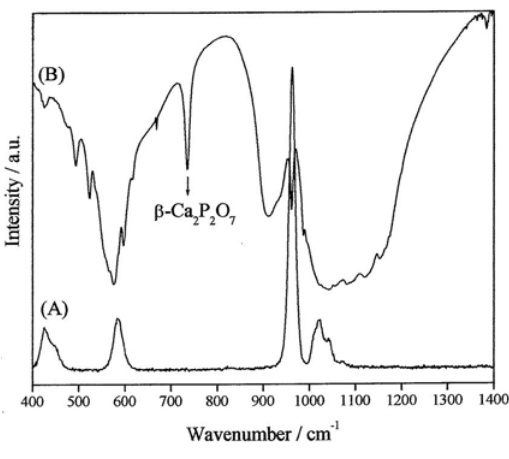
Fig. 5 – (a) Raman and (b) IR spectra of the hydroxyapatite inorganic replica.